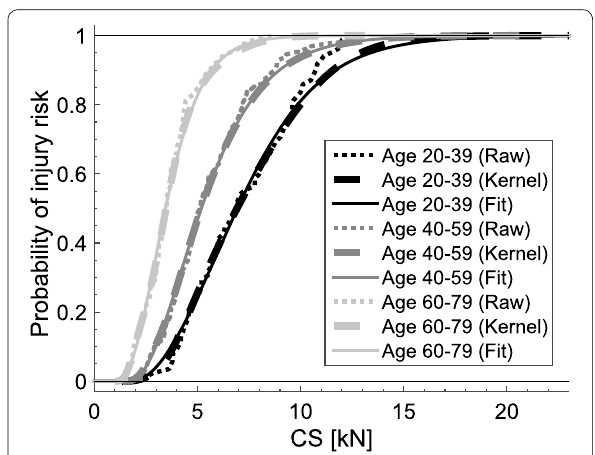
Fig. 4 Risk curves for three generations, fitted to Eq. 8. CS, compressive strength